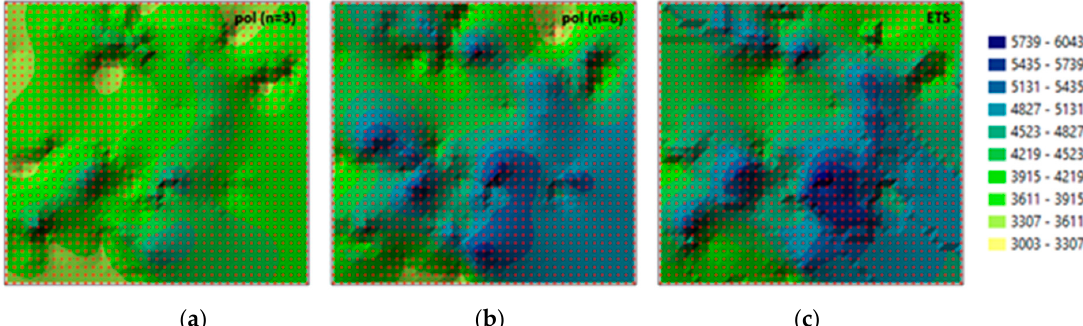
Figure 9. Interpolation surfaces of real estate prices forecast for 2012 based on the GRID nodes generated with the use of various methods (in the absence of the 2012 epoch); ( a ) 3rd degree polynomial; ( b ) 6th degree polynomial; ( c ) ETS. Source: own elaboration.